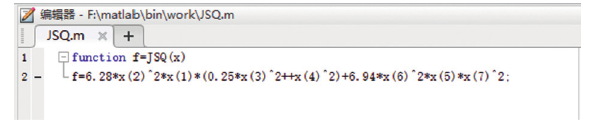
Figure 4: M file of the objective function.